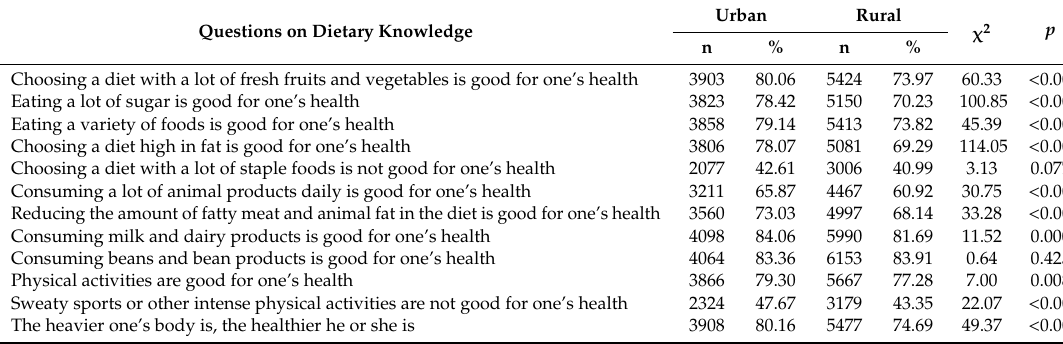
Table 3. The number and proportion of respondents who correctly answered questions on dietary knowledge.